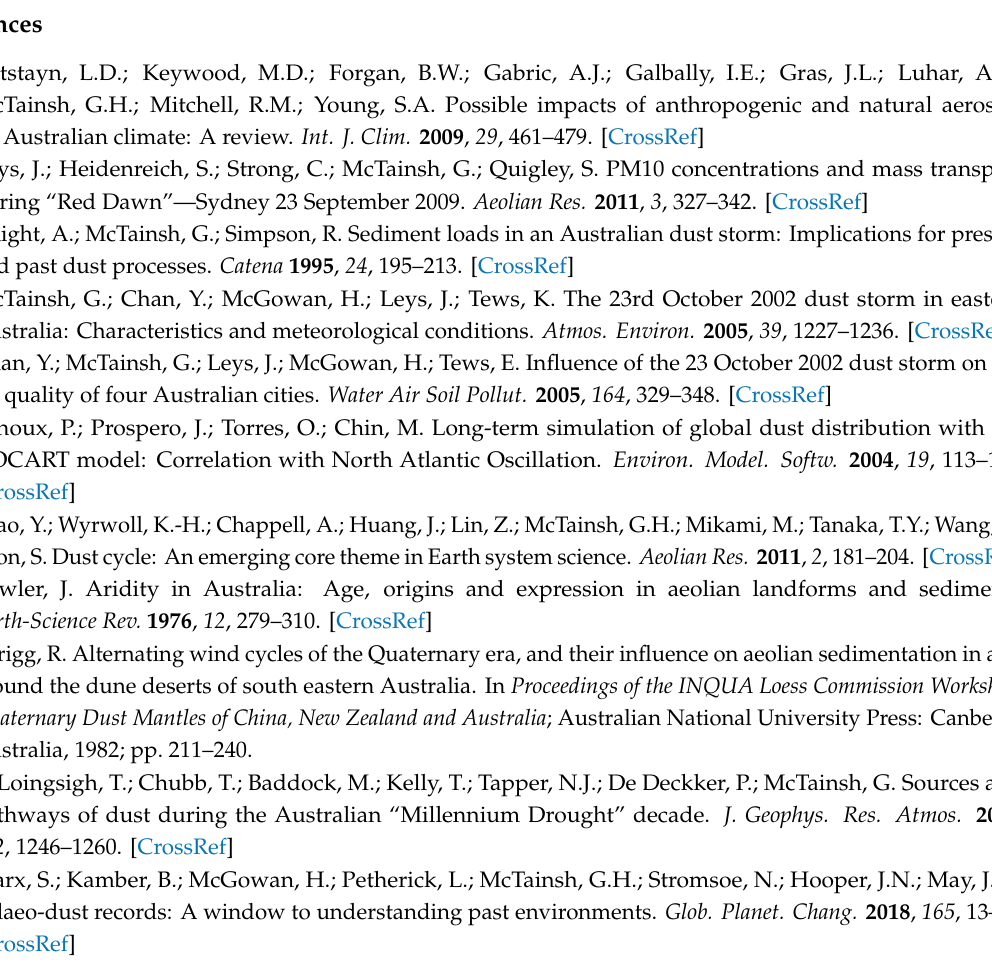
Figure A4. Daily average AOD for 13 (top) and 14 February 2019 (bottom) as measured by MODIS Aqua (left) and Terra (right) between Australia, New Zealand and Antarctica (https://giovanni.gsfc.nasa.gov/).